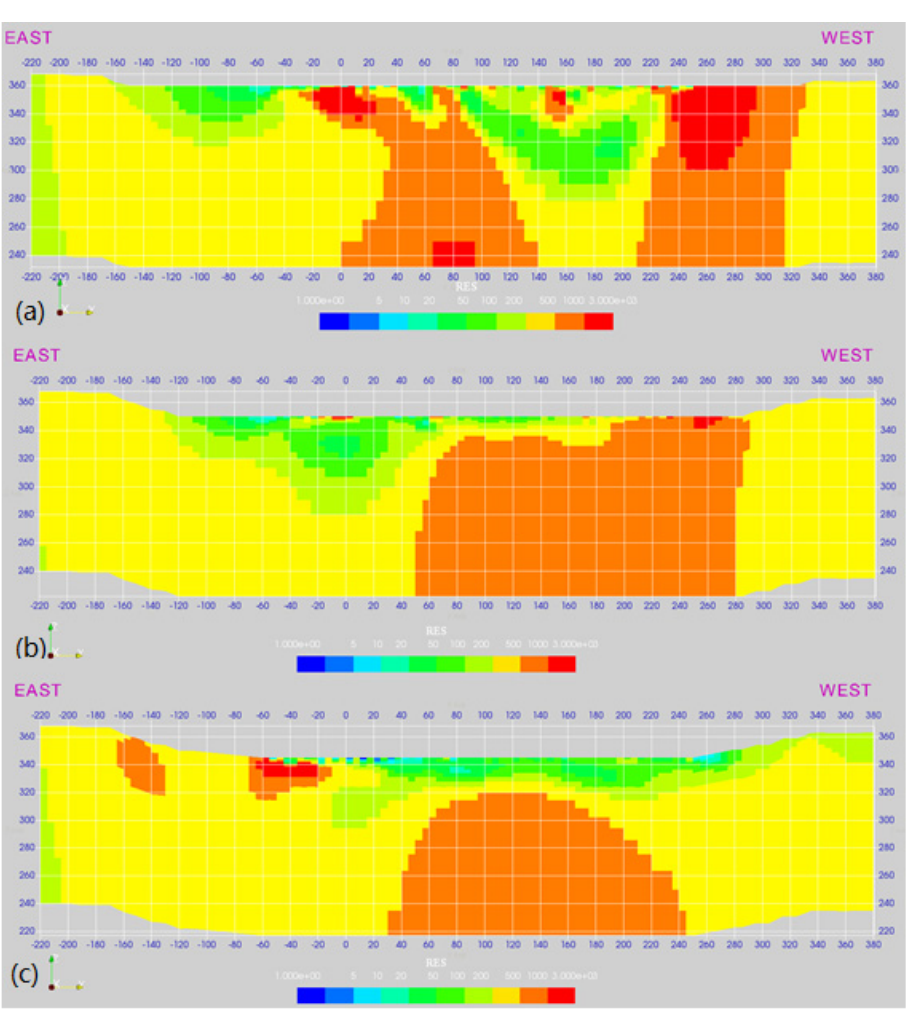
Figure 5. Sectional view of pseudo − 3D resistivity inversion results of ( a ) profile 1, ( b ) profile 2, and ( c ) profile 3 in the Xiaojiashan Reservoir.